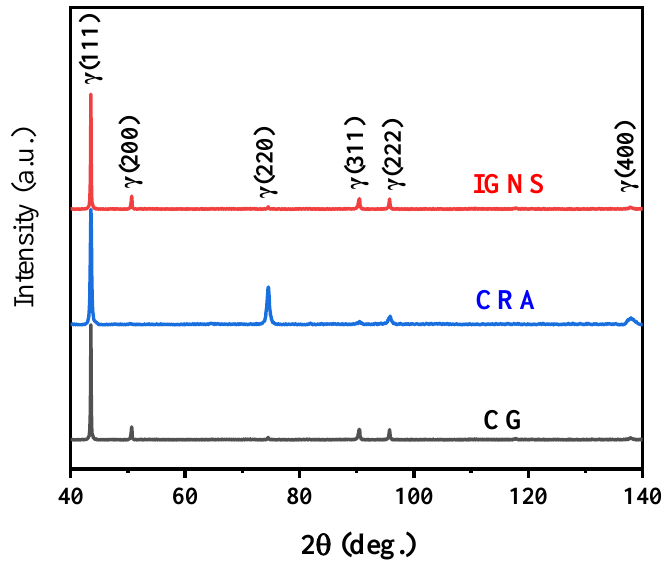
Figure 4. XRD profiles of the samples in various conditions.